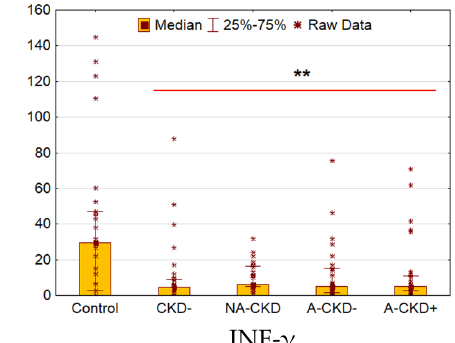
INF- γ Figure 4. Serum concentrations of IL-10 and INF- γ (pg/mL). CKD − : The group of individuals with Figure 4. Serum concentrations of IL-10 and INF- γ (pg / mL). CKD − : The group of individuals with estimated glomerular filtration rate(eGFR) ≥ 60 mL / min / 1.73 m 2 and urinary albumin-to-creatinine estimated glomerular filtration rate(eGFR) ≥ 60 mL/min/1.73 m 2 and urinary albumin-to-creatinine ratio (UACR) < 3.0 mg / mmol; NA-CKD: Non-albuminuric chronic kidney disease, the group of ratio (UACR) <3.0 mg/mmol; NA-CKD: Non-albuminuric chronic kidney disease, the group of individuals with eGFR < 60 mL / min / 1.73 m 2 and UACR < 3.0 mg / mmol; A-CKD − : Group of patients individuals with eGFR <60 mL/min/1.73 m 2 and UACR <3.0 mg/mmol; A-CKD − : Group of patients with eGFR ≥ 60 mL / min / 1.73 m 2 and UACR ≥ 3.0 mg / mmol; A-CKD + : Group of individuals with eGFR < 60 mL / min / 1.73 m 2 and UACR ≥ 3.0 mg / mmol. ** p < 0.01 vs. control; Mann–Whitney test and